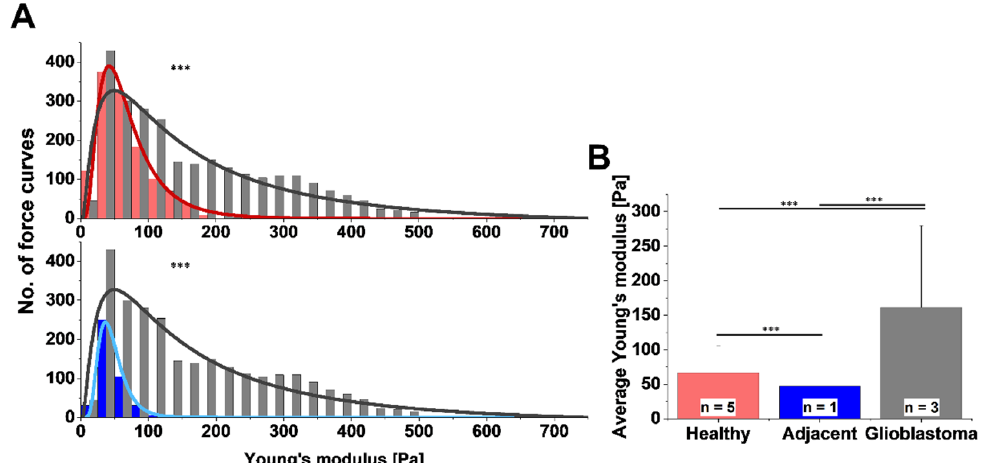
Figure 5. Variation in nanomechanical properties among different brain tissues. AFM-measured ( A ) distribution and ( B ) mean values of Young’s modulus for healthy brain tissue (red), tissue adjacent to GB (blue), and GB tissue (gray). Statistical differences were measured using Kolmogorov–Smirnov test and unpaired Student’s t -test. *** p ≤ 0.001. Figure adapted with permission from Ref. [16]. 2020, Cie´sluk